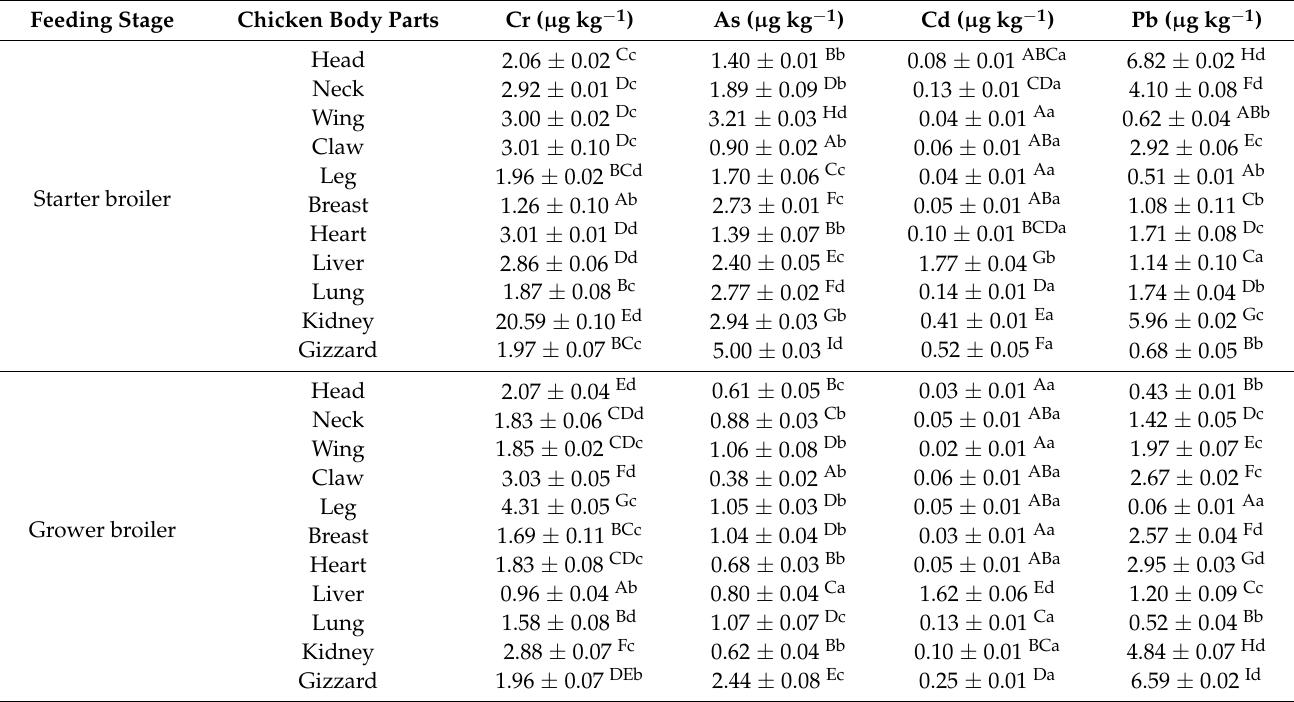
Table 3. Toxic elements in different body parts of chicken during the feeding